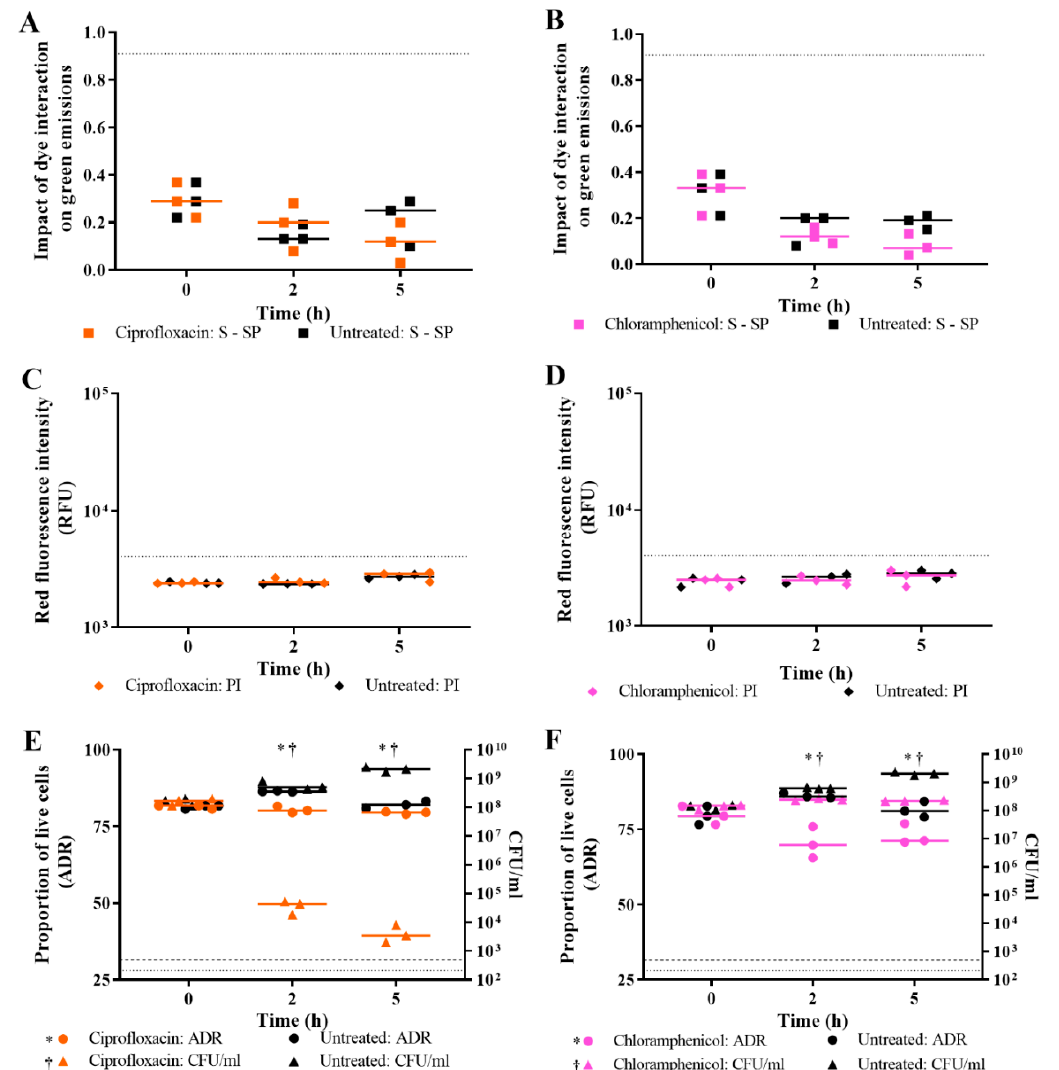
Figure 5. Live/dead spectrometry and culture-based enumeration of E. coli challenged with non-lytic antibiotics. At 0 h, 2 h, and 5 h time points, viability of E. coli MG1655 challenged with ~1 × MBC of ciprofloxacin (orange), ~1 × MIC of chloramphenicol (pink), and an untreated control (black) was determined by measuring fluorescence of SYTO 9- and/or PI-stained cultures using the Optrode ( A – F ) and by culture-based enumeration ( E , F ). Fluorescence intensities were obtained from integrating 505–515 nm for green emissions and 600–610 nm for red emissions. The proportion of live cells in the sample population was determined by the impact of the quenching/enhancement dye interaction on green emissions ( A , B ); level of red emissions ( C , D ); and the adjusted dye ratio (ADR; E , F ). The dotted lines represent the equivalent value for isopropanol-killed cells. The limit of detection for culture-based enumeration is 500 CFU/mL (dashed line). Data presented is from three biological replicates with a line plotted at the median. Statistical significance for the difference between treated and untreated at each time point is represented by * for fluorescence and † for plate counts (two-way RM ANOVA, p value: <0.05, Sidak’s multiple comparisons